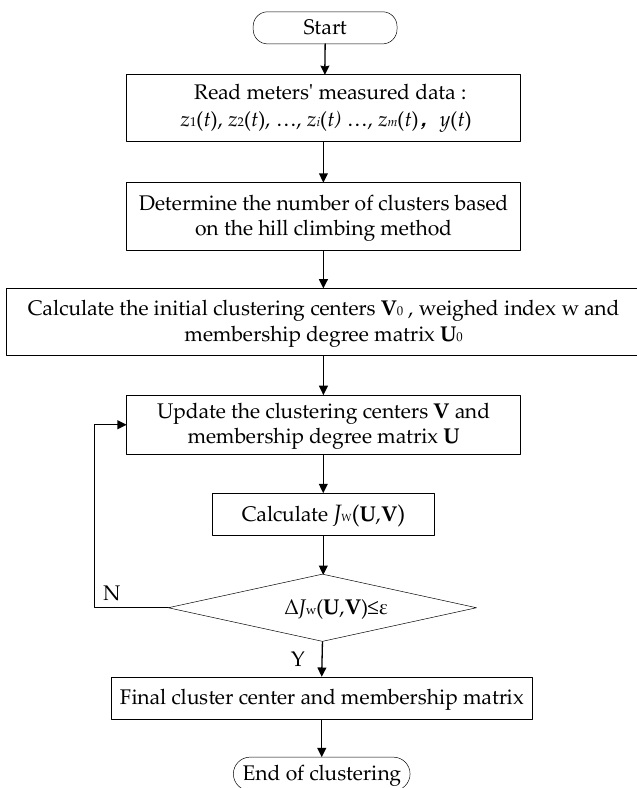
Figure 3. Flow chart of our improved fuzzy clustering algorithm clustering for measured data.